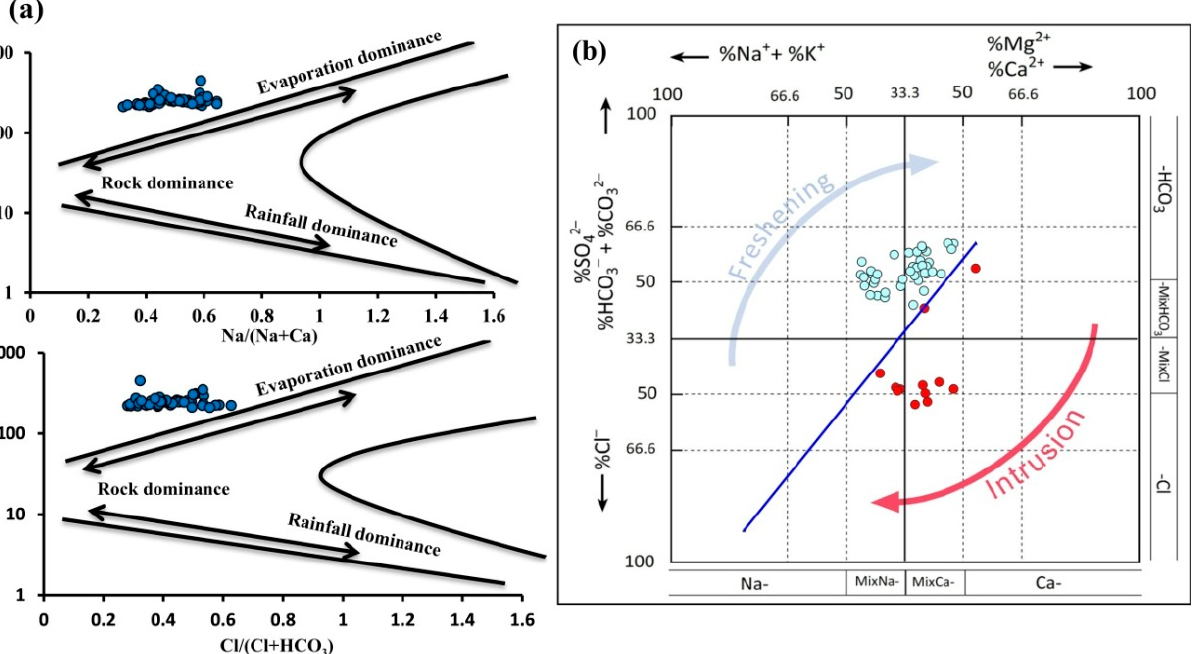
Figure 5. Geochemical controlling mechanisms influencing water quality in the Nile River: ( a ) Gibbs diagram and ( b ) hydrochemical facies evolution diagram